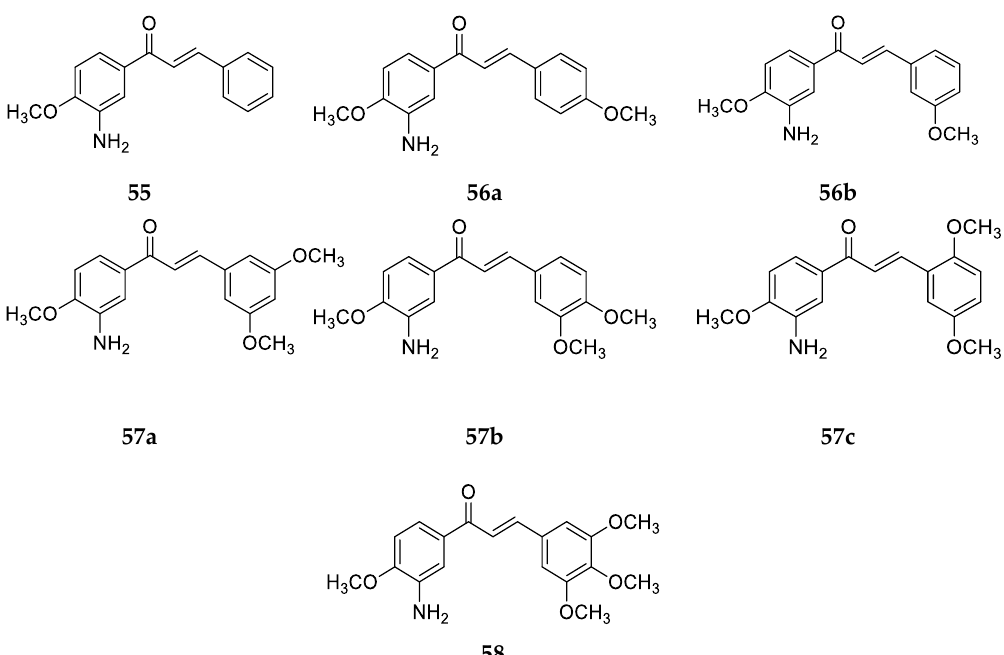
Figure 32. Chemical structures of 3-aminochalcone derivatives with methoxy substitution on rings A and B.